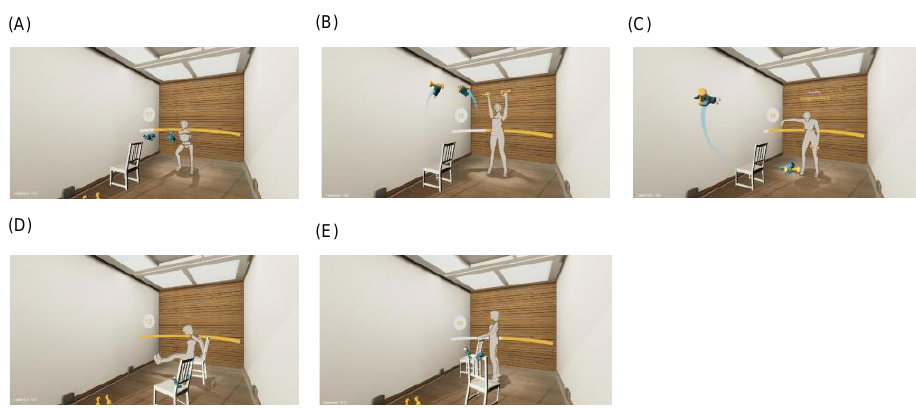
Figure 3. Five exercises of the SET exergame: ( A ) squat; ( B ) overhead press; ( C ) lateral raise; ( D ) leg raise; ( E ) heel raise.